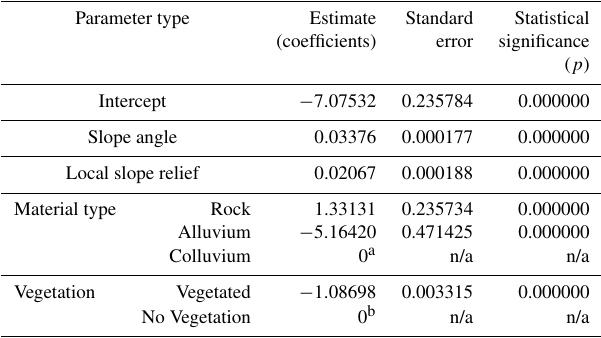
Table B1. Summary table of coefficient estimates for the variables used in the Fox study area logistic regression equation.